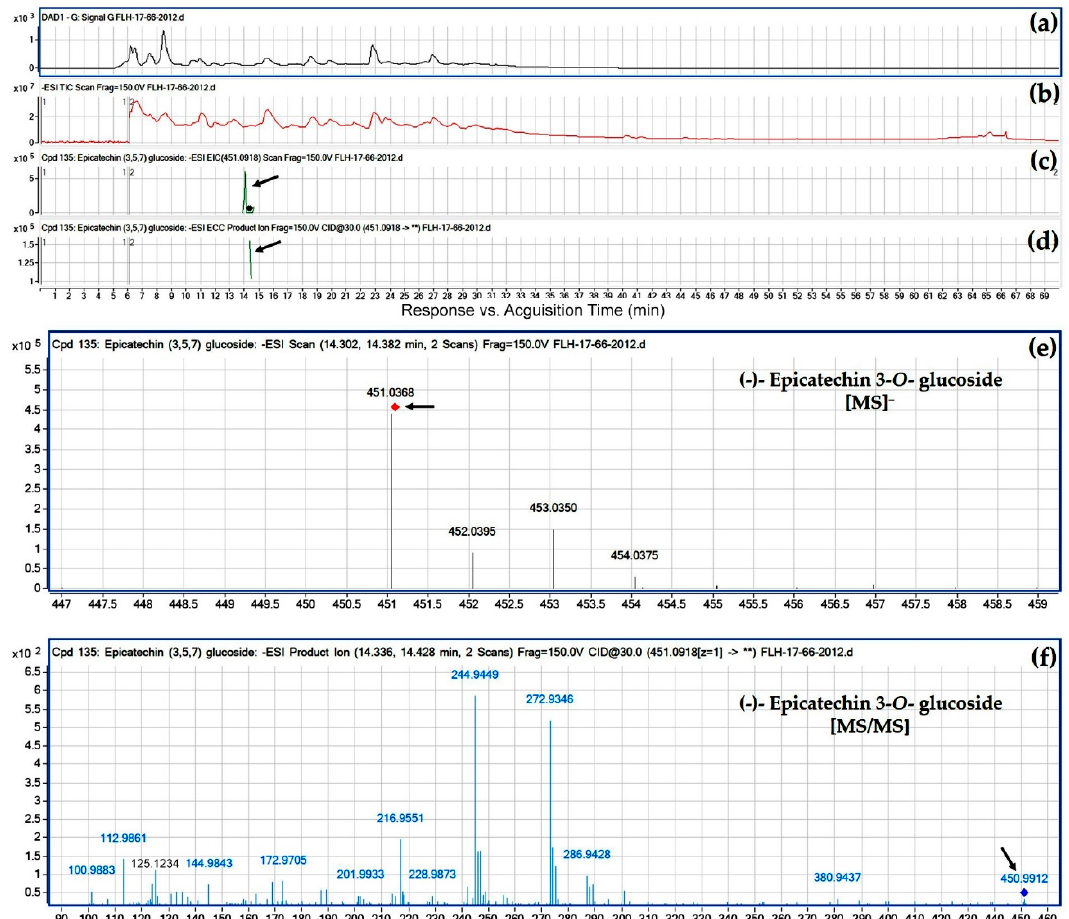
Figure 6. Extracted ion chromatogram (EIC) of primary mass spectrum (MS1) and m / z features of secondary ion fragments (MS2) derived from LC-MC/MS annotate this peak to be ( − )-epicatechin 3- O -glucoside (MW, 452.41). ( a ) Chromatogram of FLH 17-66 extracts (2012) recorded at 280 nm; ( b ) total ion chromatogram of FLH 17-66 extract (2012); ( c ) EIC of primary ion 451.0918 [M − H]¯; ( d ) enhanced charge capacity (ECC) ion product for m / z 451.0918; ( e ) a MS profile showing an extracted m / z value, 451.0368; and ( f ) fragments from collision-induced dissociation (CID) of m / z 451.0368 showing m / z 124.9861, 172.9705, 244.9449, 272.9346, 286.9428, and 300.9102 (Table 1).